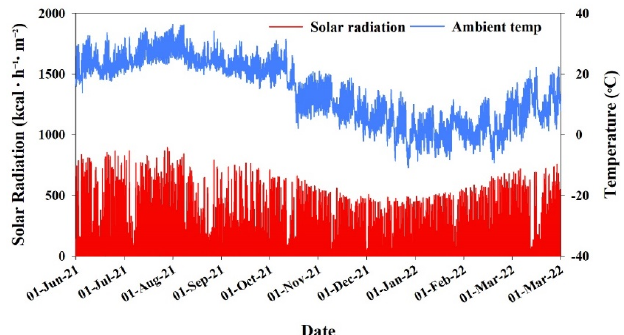
Figure 5. Ambient solar radiation and temperature at Kyungpook National University, Daegu, South Korea (latitude 35.53° N, longitude 128.36° E, elevation 48 m).